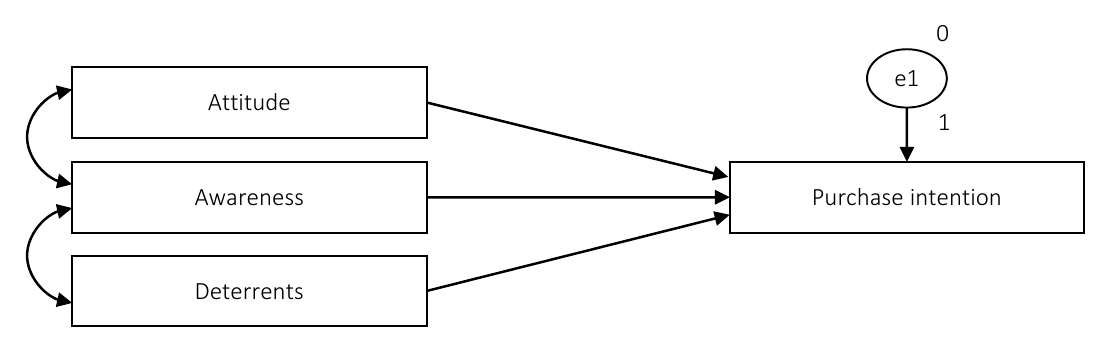
Figure 2. Model of hypotheses and variables